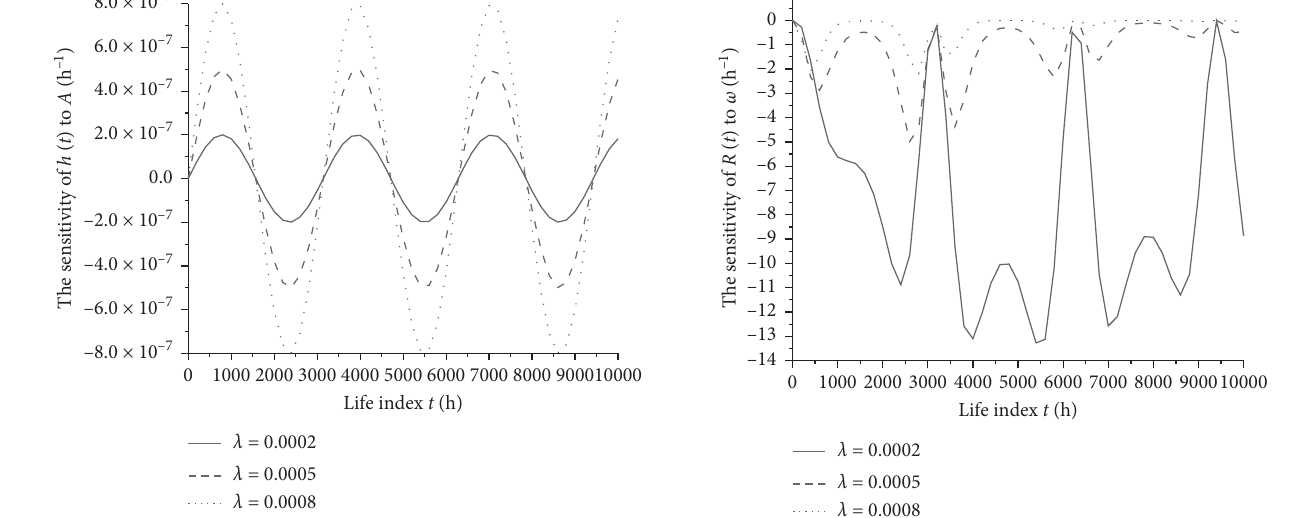
Figure 23: The sensitivity of R ( t ) to 2 ω ( λ � 0.0002/0.0005/0.0008).